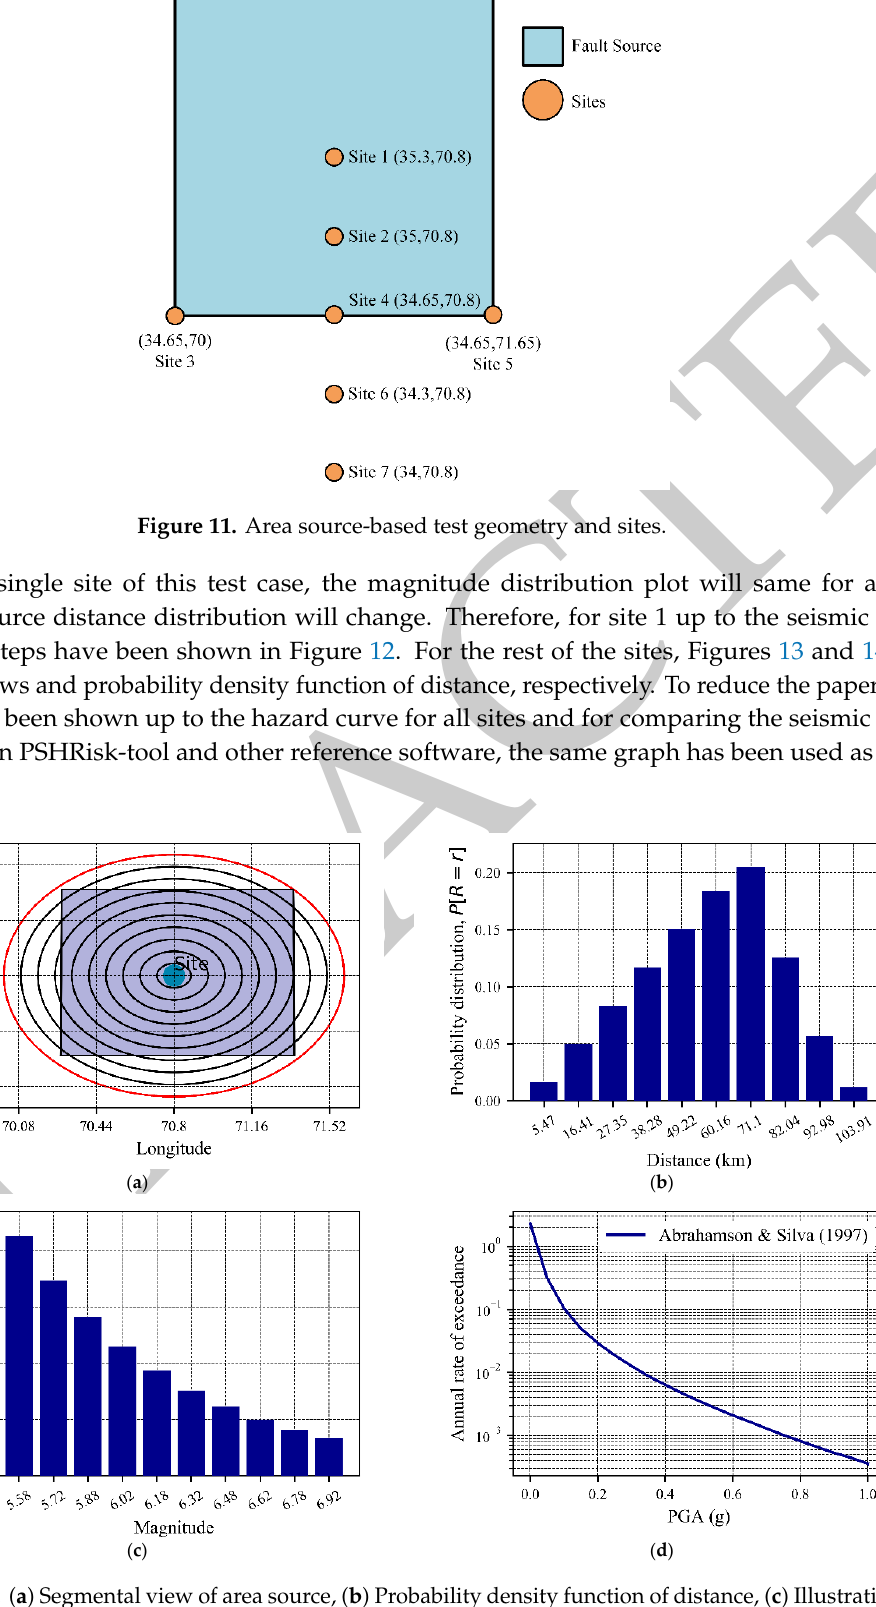
Figure 12. ( a ) Segmental view of area source, ( b ) Probability density function of distance, ( c ) Illustration of probability density function for magnitude for a source with a truncated Gutenberg–Richter distribution, ( d ) Probabilistic seismic hazard curve, respectively for Site 1 by PSHRisk-tool.